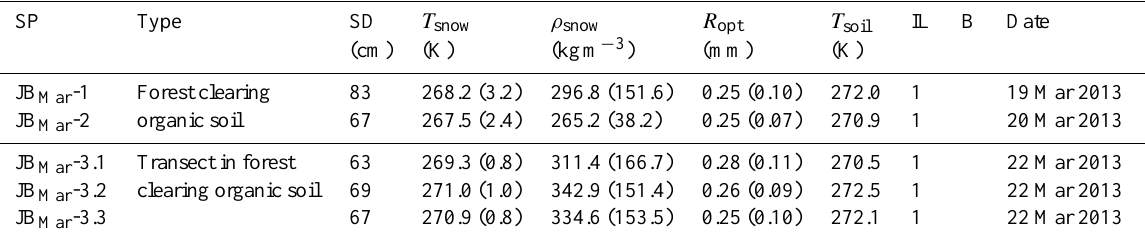
Table 3. Same as Table 1 but for James Bay sites in March (JB Mar ) . SP